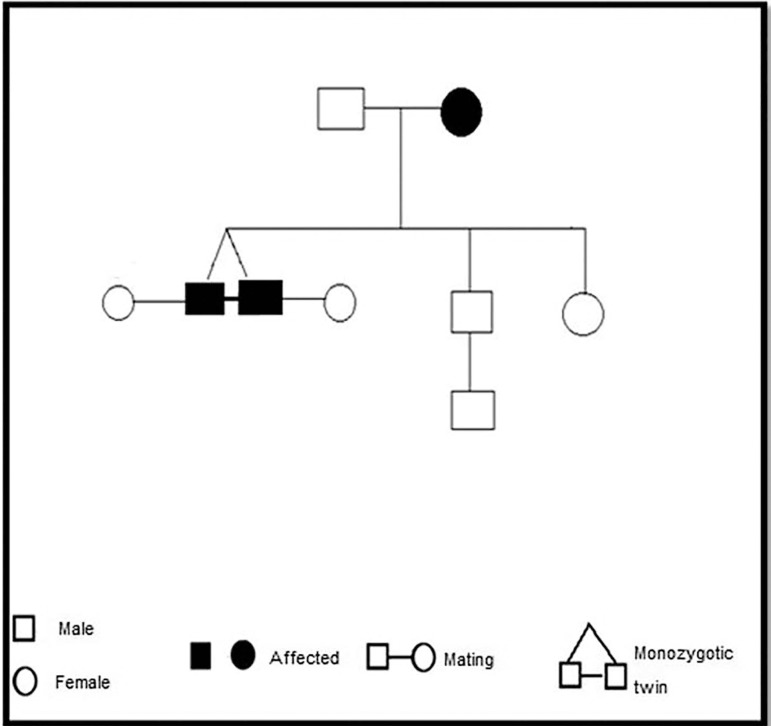
Familial pedigree.